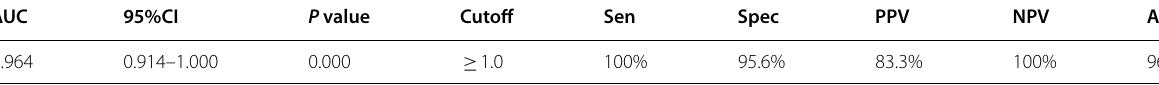
Table 6 ROC curve analysis in differentiating molecular type A through ADC value